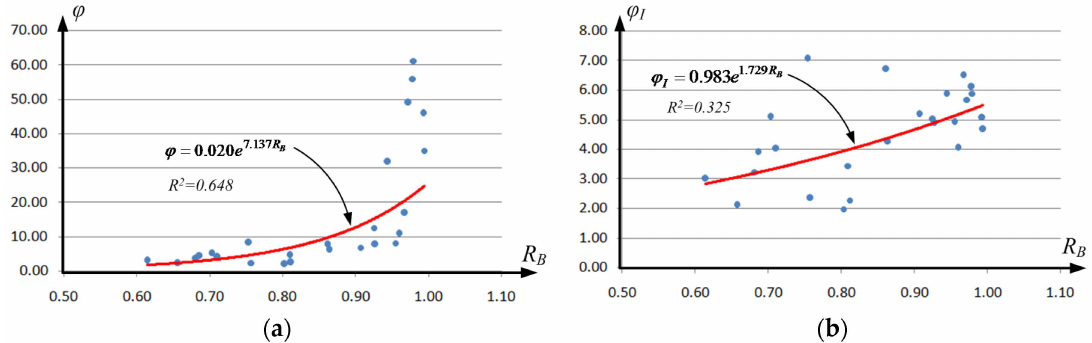
Figure 7. Resistance vs. base resilience for the data points in Table 2 and trend curve equations. ( a ) Resistance for multiple loads; ( b ) Individual resistance.